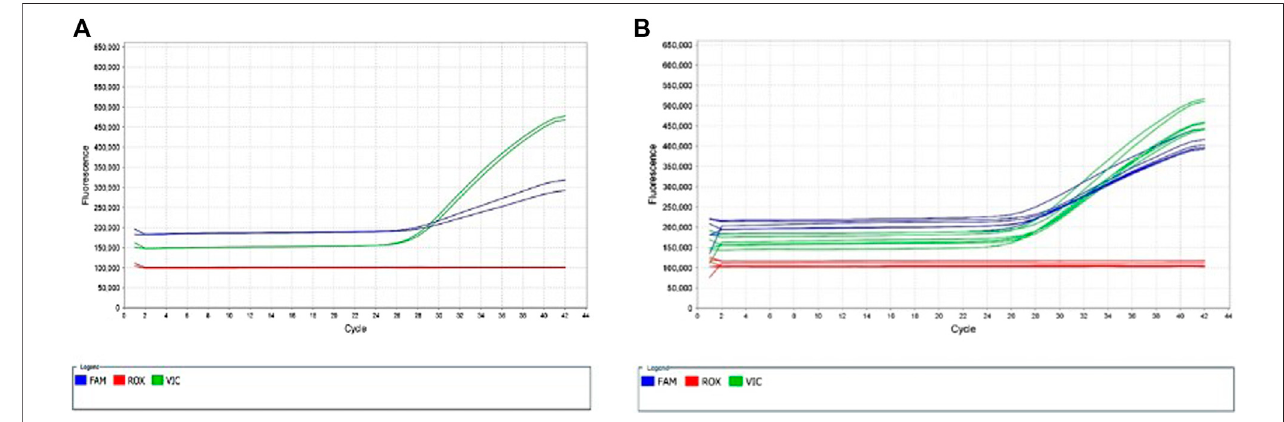
FIGURE 2 | Multicomponent Plots for ANPRV67 (rs10484555). (A) Fluorescence of both VIC and FAM dyes indicate a heterozygous call for sample NA17019. A homozygous G/G sample would show solely fl uorescence of the VIC dye. (B) Fluorescence of both VIC and FAM dyes from remainder of heterozygous samples (green circles in Figure 1 , samples 738, HG00463,